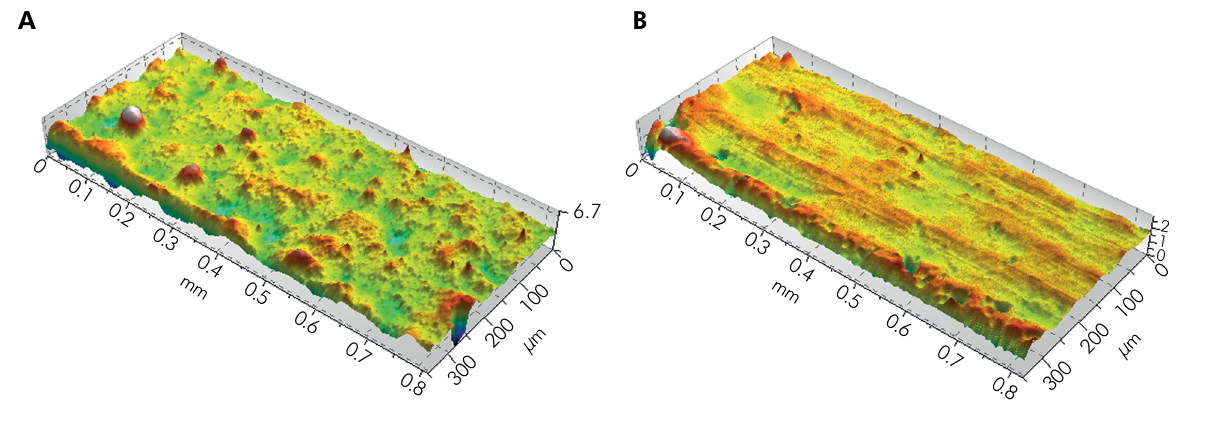
Figure 4. 3D profilometry images of A) Titanol Cosmetic; and B)